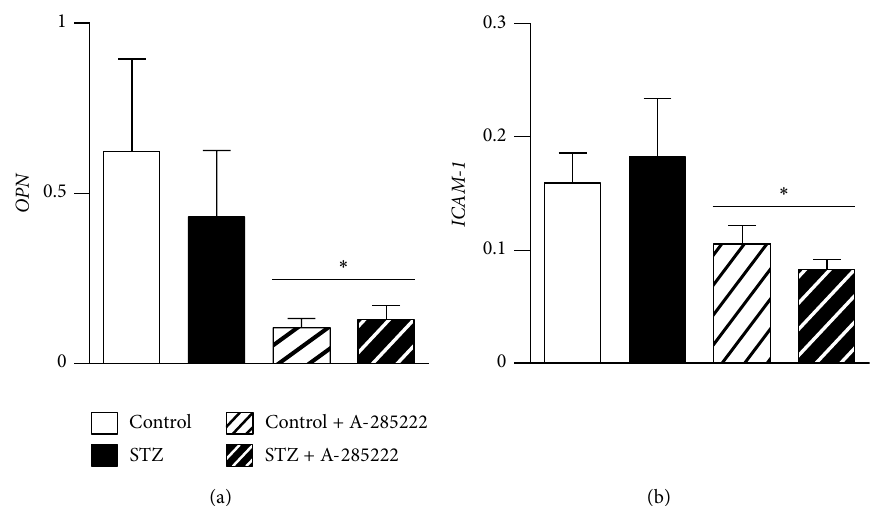
Figure 6: In vivo inhibition of NFAT reduces the expression of OPN and ICAM-1 in retinal vessels. mRNA expression of (a) OPN and (b) ICAM-1 in isolated retinal vessels from BALB/c mice treated with STZ (60mg/kg) or vehicle (citrate buffer). Mice received for 4 weeks daily i.p. injections of A-285222 (0.29 mg/kg for 2 weeks followed by 0.15 mg/kg until termination) or vehicle (saline). Expression levels were determinedbyquantitativeRT-PCRand HPRT wasusedasendogenouscontrol. 𝑁 = 7 -8mice/group.Two-wayANOVArevealedasignificant effect of A-285222 on OPN and ICAM-1 expression; ∗ 𝑃 < 0.05 .